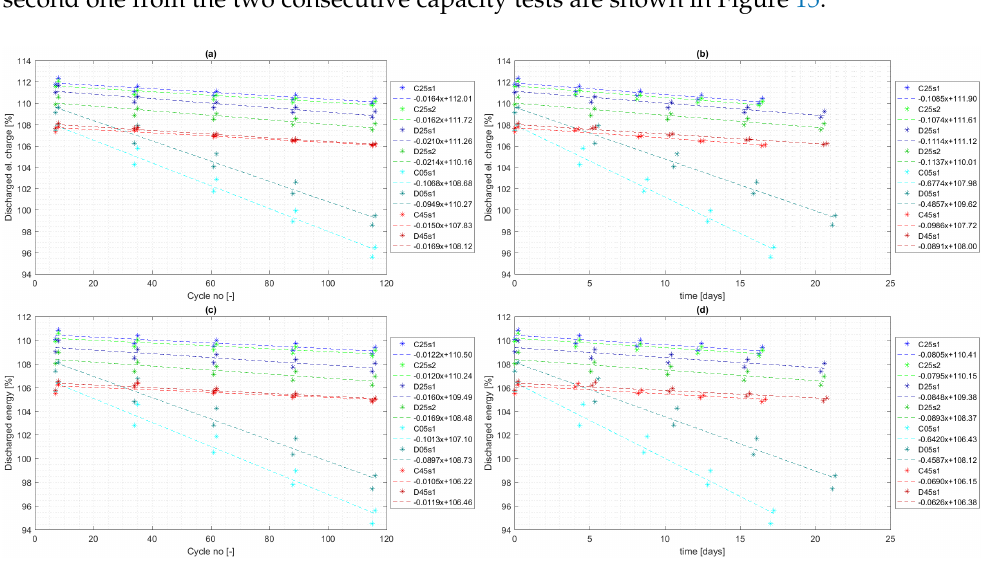
Figure 13. Raw capacity fade and energy decrease measured and regressed for all cycle aging cells for capacity test cycles depending on cycle no. and time. All the drive cycle samples have longer duration compared to CC samples.